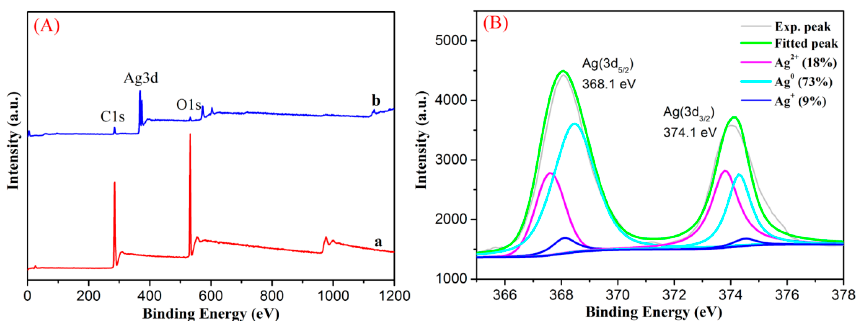
Figure 6. Survey XPS spectra of both samples ( A ): a, PVA/PAA/GO-COOH nanocomposite; b, PVA/PAA/GO-COOH@AgNPs nanocomposite at modified time of 1 h; ( B ) Ag3d deconvolution of XPS peaks in spectra b.